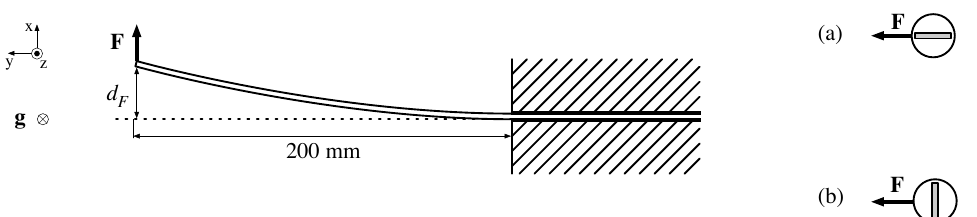
Figure 5. Test setup to measure the deformation d F of a 20 cm long probe segment as a result of a sideways force F , which is applied ( a ) in the PCB plane, or ( b ) perpendicular to the PCB